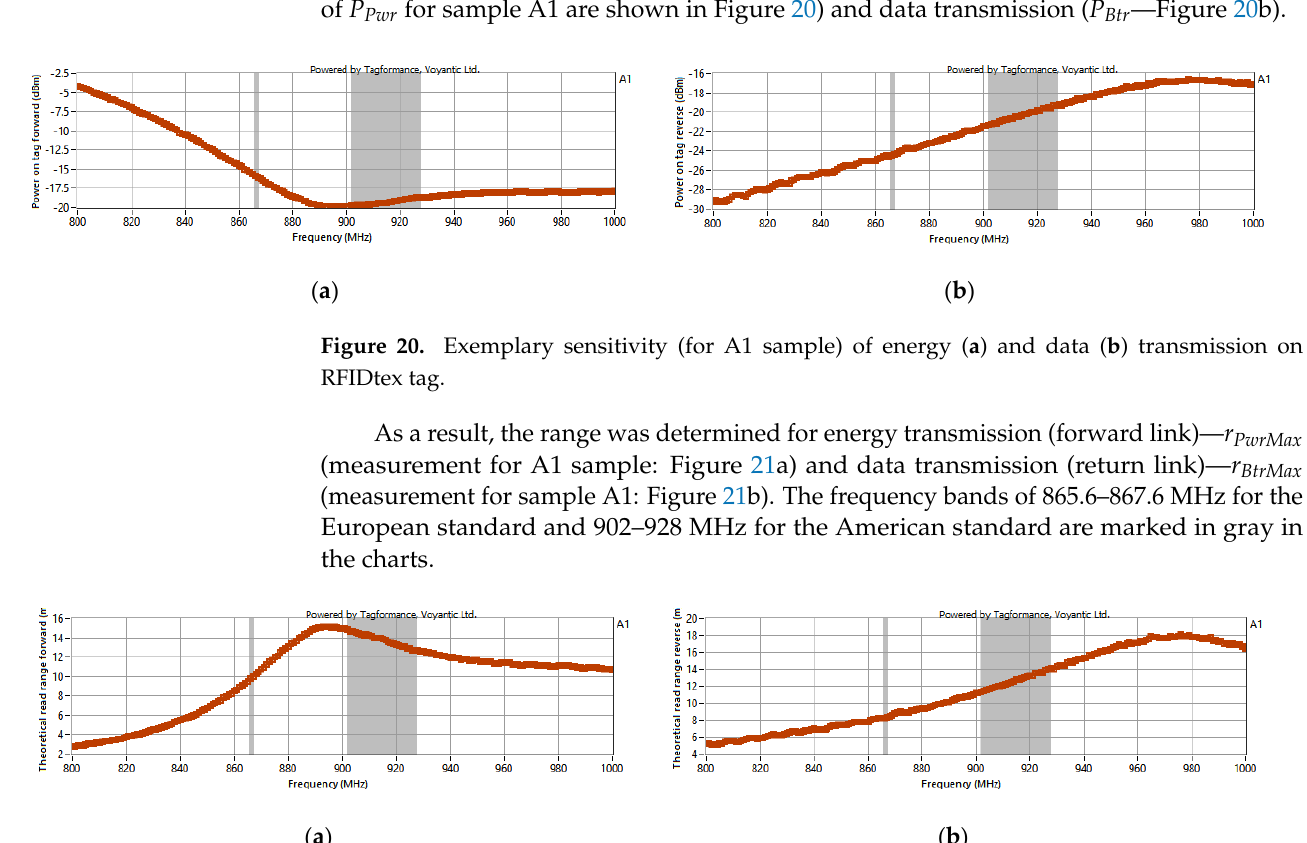
Figure 21. Exemplary range (for A1 sample) of energy ( a ) and data ( b ) transmission on RFID system.